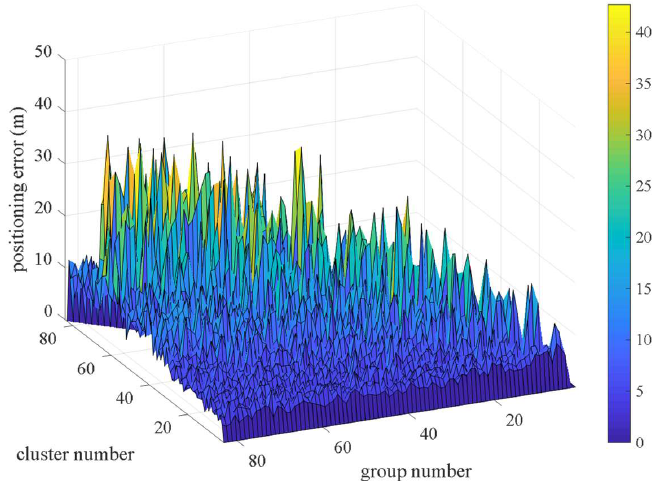
Figure 6. The positioning error changes with the cluster number and group number.